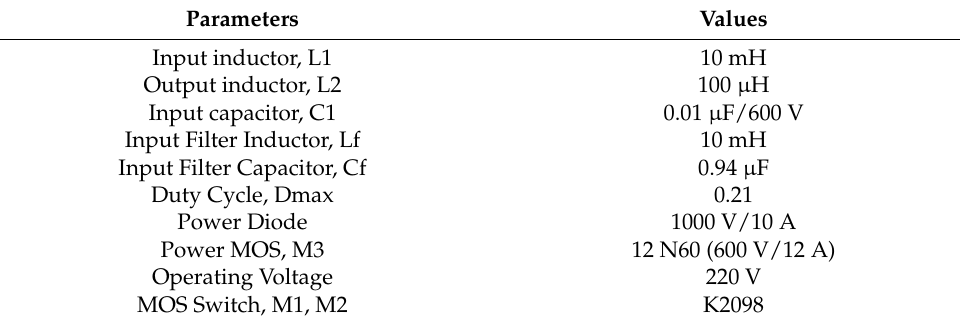
Figure 9. Composite CCT variation with change in duty cycle. Table 2. Optimized parameters used in prototype.